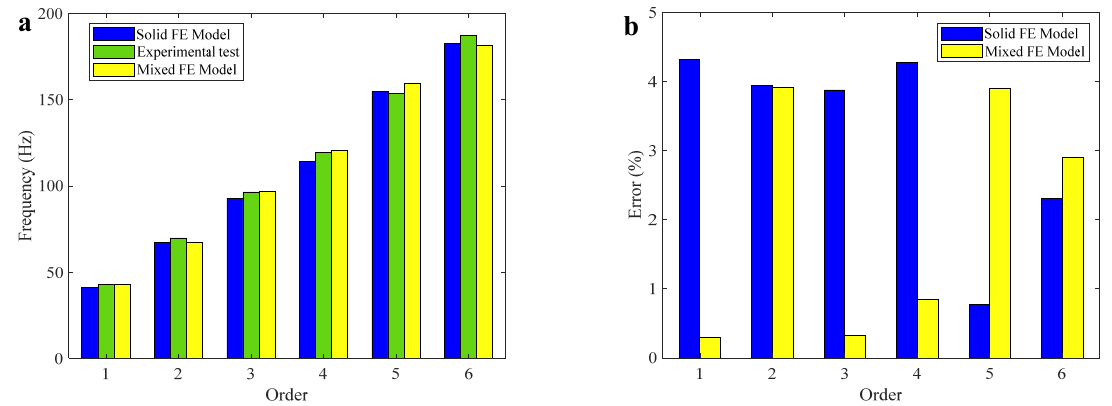
Figure 11. The frequency errors between updated model and experimental results. ( a ) The frequency of updated model and experimental results. ( b ) The frequency error of two updated models.